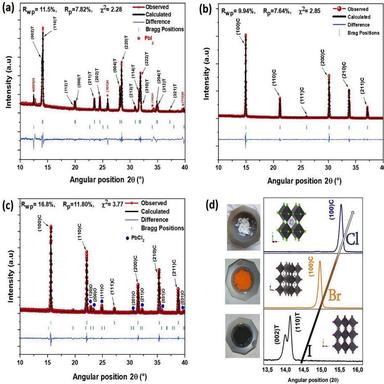
The Rietveld refinement of the XRD pattern of perovskite powders: a) MAPbI3, b) MAPbBr3, c) MAPbCl3 and d) highlighted angular position range of the XRD pattern (13.5◦–16.0◦) and powder images.